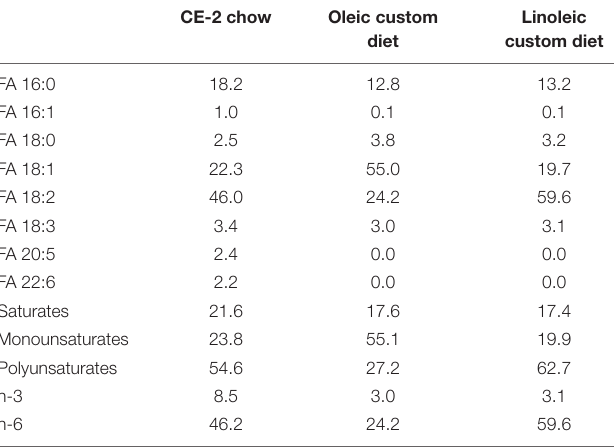
TABLE 3 | Estimation of fatty acid compositions of diets (% by weight of total fatty acids). CE-2 chow